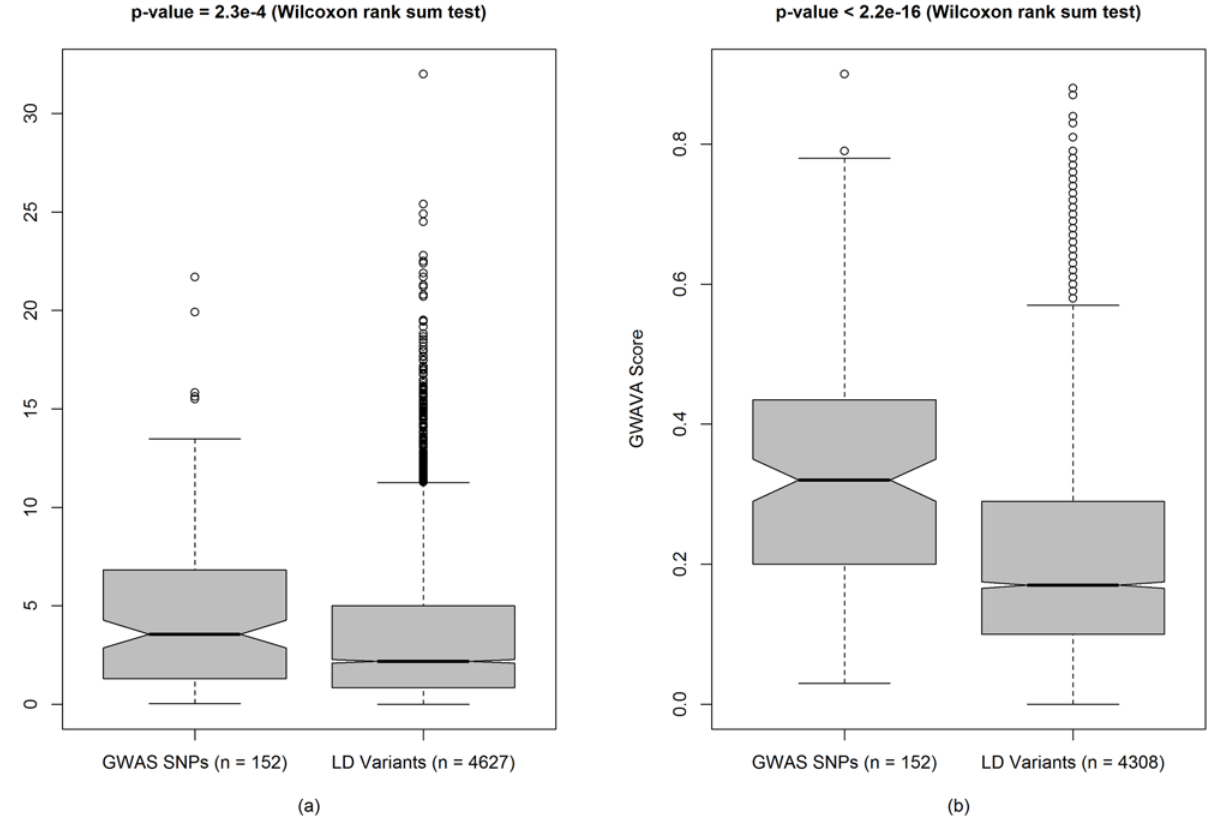
Fig 3. Comparing functional annotation scores of IBD associated lead noncoding GWAS SNPs versus LD variants. ( a ) CADD scores for GWAS (n = 152) versus LD variants (n = 4627). ( b ) GWAVA scores for GWAS (n = 152) versus LD variants (n = 4308). In the boxplots, center lines show the medians of the values and box limits indicate the 25th & 75th percentiles (as determined by R software). Whiskers extend to 5th and 95th percentiles and outliers are represented by open circle dots. The notches are defined as ± 1.58 × IQR (interquartile range) / square root of n and represent the 95% confidence interval for each median (default in R software). P-values are calculated using two-sided Wilcoxon rank sum test.